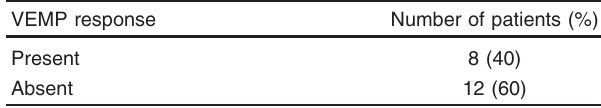
Table 3 Distribution of vestibular-evoked myogenic potential response in patients with multiple